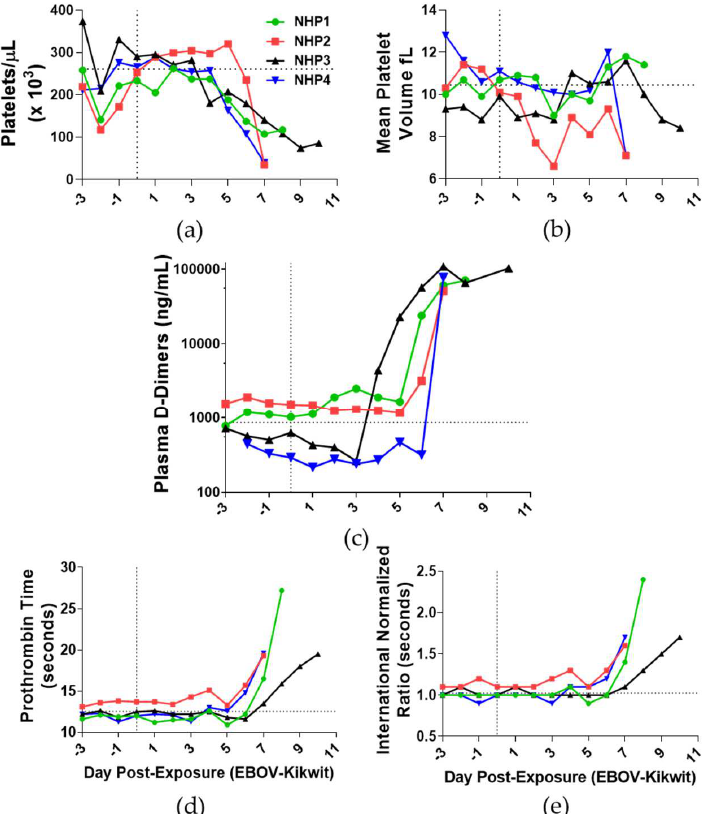
Figure 7. Assessment of platelets and clot formation in the blood of aerosol EBOV-challenged rhesus macaques. Blood ( a ) platelets, ( b ) mean platelet volume, ( c ) plasma D-dimers, ( d ) prothrombin time, and ( e ) international normalized ratio were analyzed in samples collected 3 days prior to exposure and DPE 0–10. DPE 0 is marked by a black vertical dot line. The black horizontal dashed line is the average of all animals for DPE 0.